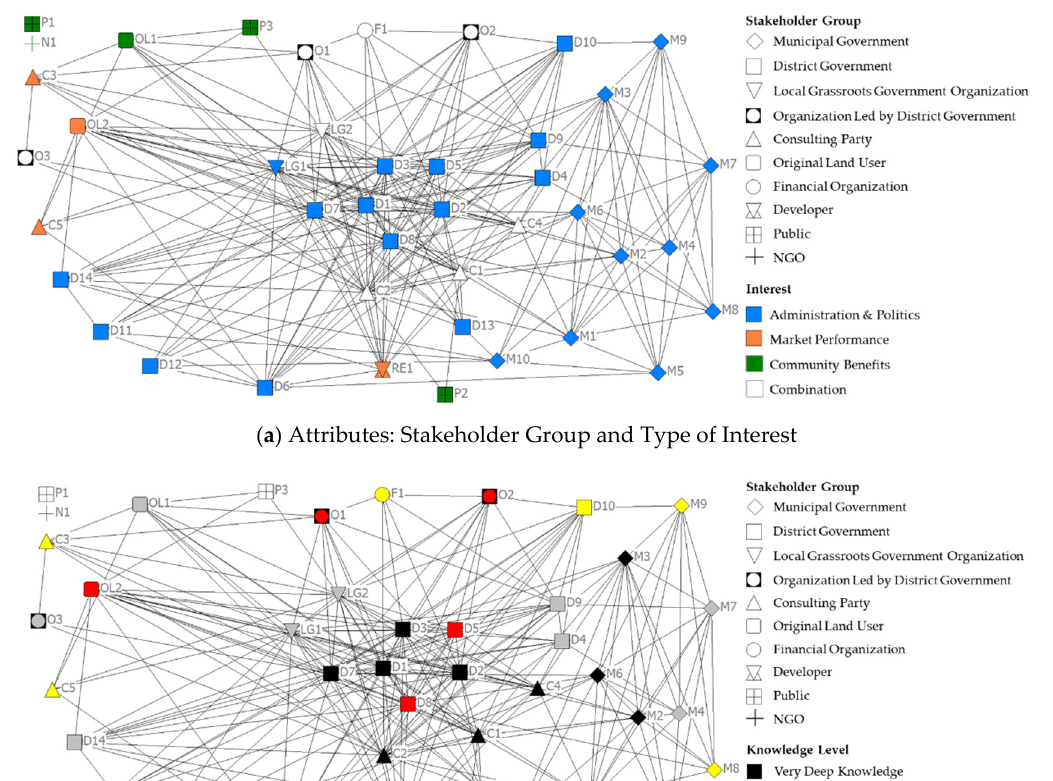
Table 3. The centrality measures of various stakeholders.